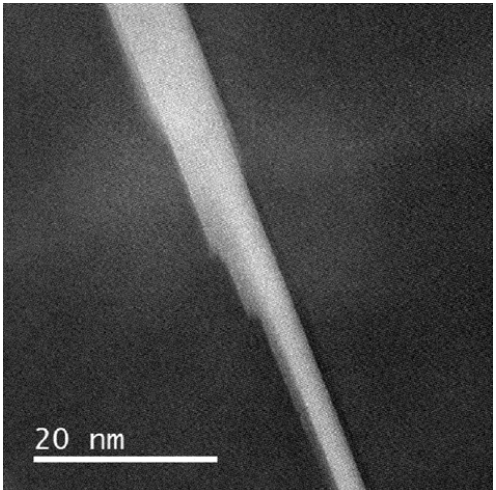
Figure 13. HAADF image of a θ (cid:48) precipitate documenting that the growth mechanism is dominated by Figure 13 . HAADF image of a  ' precipitate documenting that the growth mechanism is dominated ledges formed at the by ledges formed at the interface.